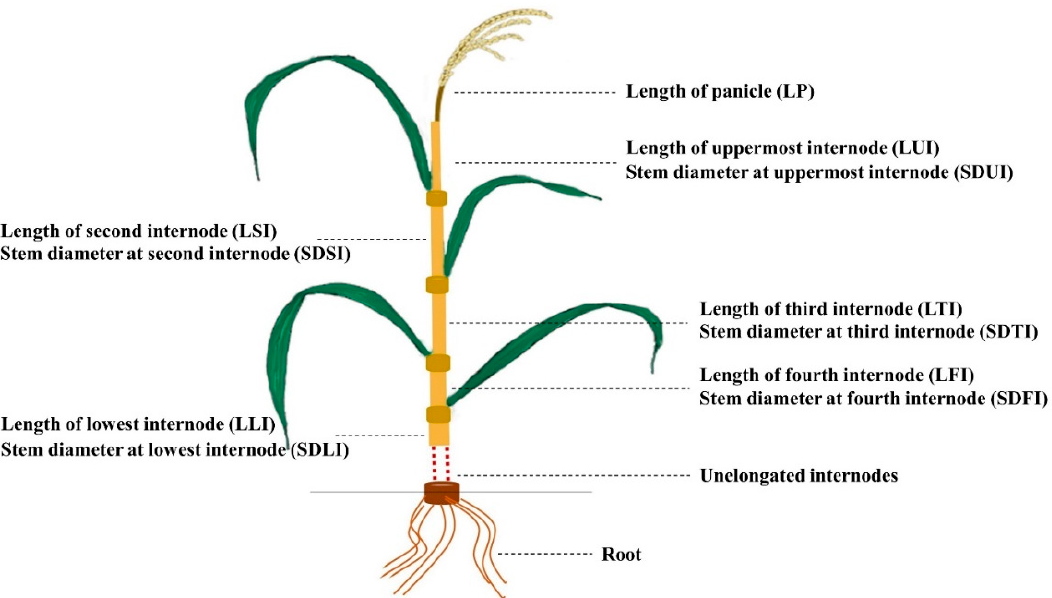
Figure 1. The image shows the location of each sampled part of the rice plant. Table 1. Comparative analysis of the length of each internode and the stem diameter of each internode in 120 CNDH population and their parents “Cheongcheong” and “Nagdong”. Parents Plant Traits Year DH Population Cheongcheong Nagdong.